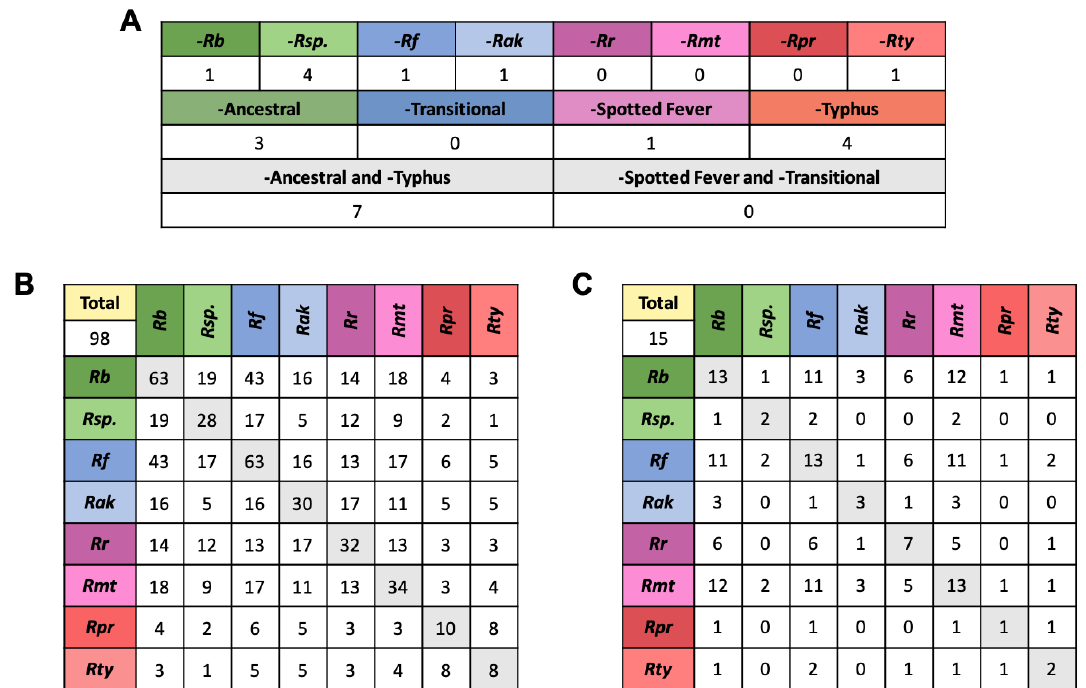
Figure 6. Representation of GL1,2,3 EHSs across Rickettsia . ( A ) shows the GL1 genes that are absent in a single species, a single group, or a combination of groups, indicating the evolutionary node at which a gain or loss event likely occurred. ( B , C ) show the number of putative effectors from the GL2 and GL3 group, respectively, that are present in every species, as well as how many they share with other species. This shows patterns of shared genes between distantly related species. For an example of how homologs are placed in these tables see Figure S1. The 2 – 3 letter labels correspond to species with Rb standing in for R. bellii str. RML396-C, Rsp. for R. sp. MEAM1 ( B. tabaci ), Rf for R. felis str. URRWXCal2, Rak for R. akari str. Hartford, Rr for R. rickettsia str. Sheila Smith, Rmt for